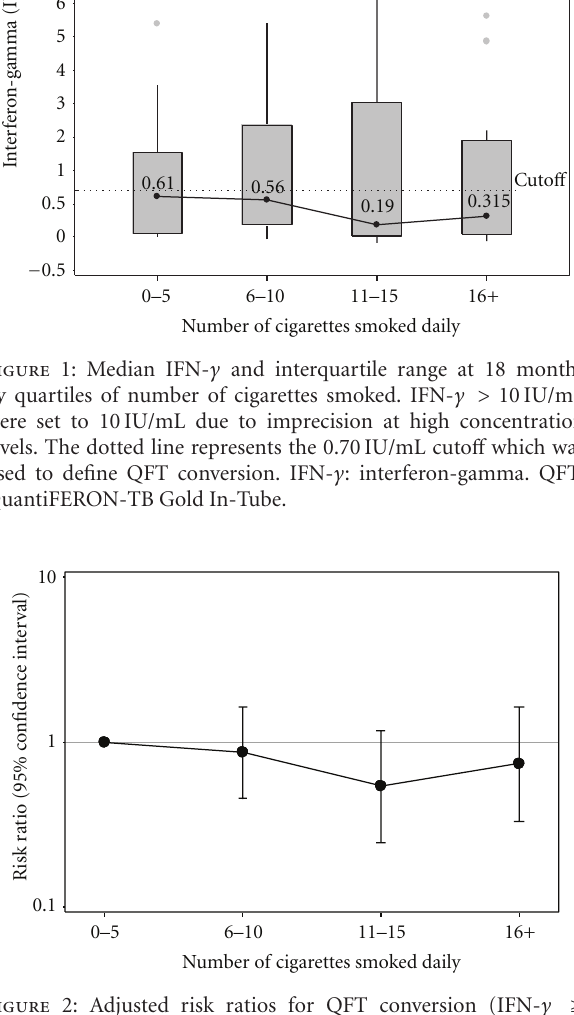
Figure 2: Adjusted risk ratios for QFT conversion (IFN- γ ≥ 0.70 IU/mL) at 18 months based on the final multivariable Poisson regression model with robust variance which included the following covariates: quartiles of the number of cigarettes smoked daily, education, age, gender, and alcohol use. IFN- γ : interferon-gamma. QFT: QuantiFERON-TB Gold